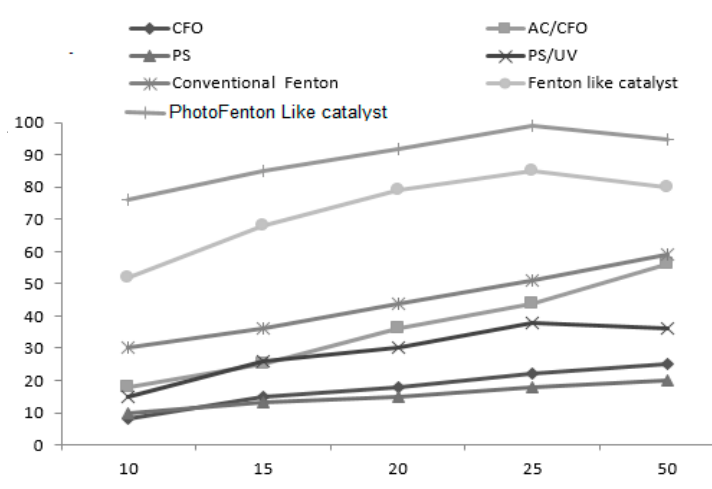
Figure 4. The removal efficiency of dye in different systems.